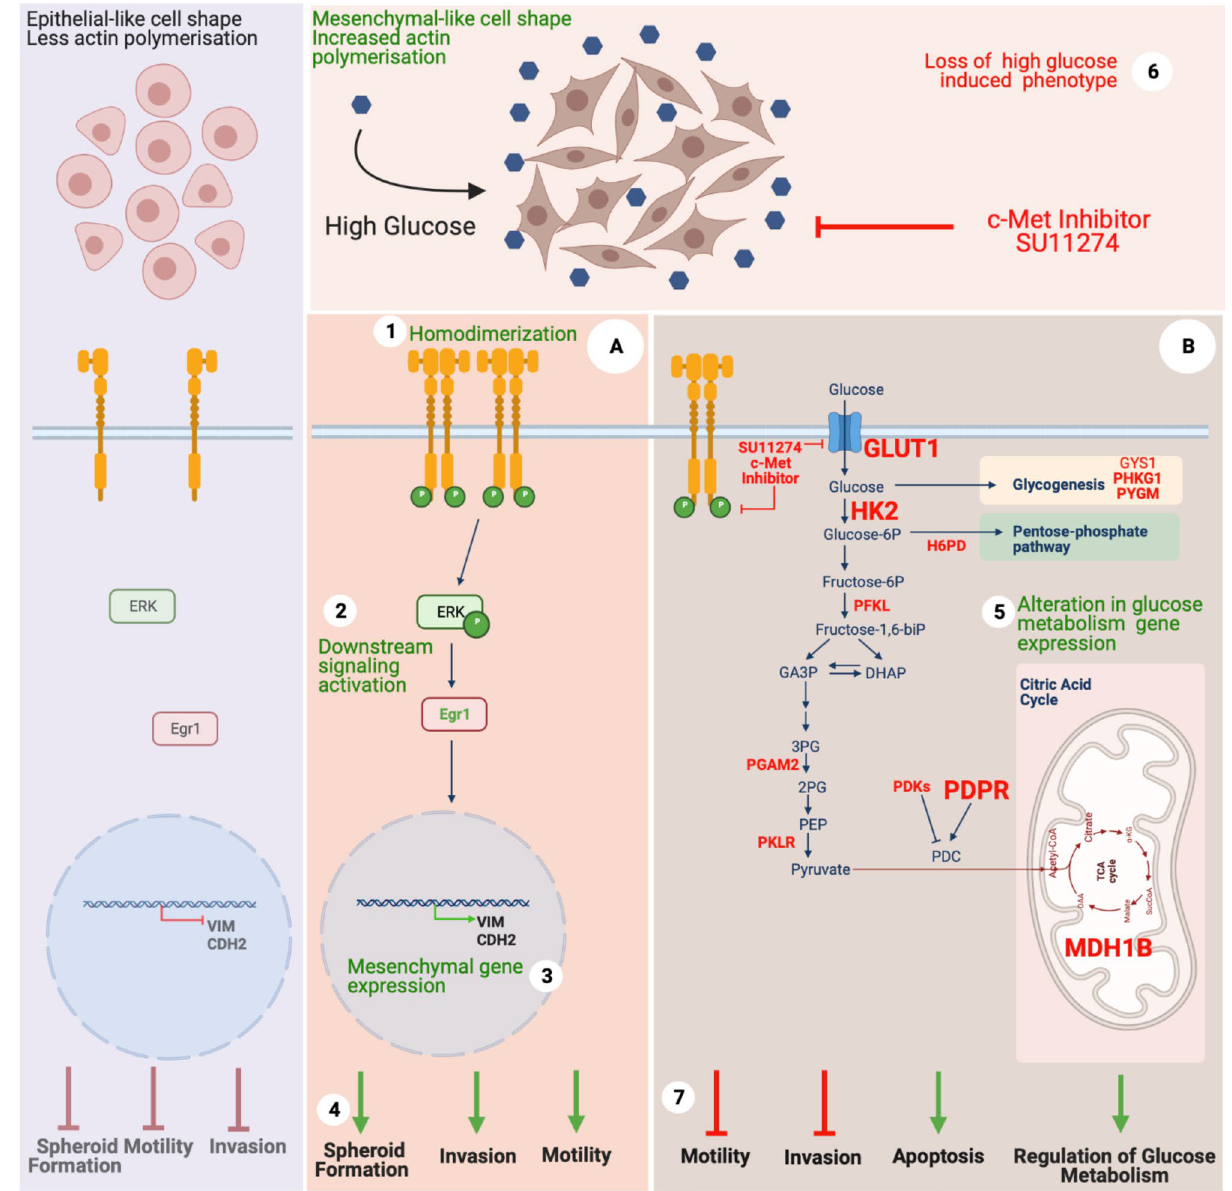
Figure 6. Graphical illustration of high glucose induced EMT via c-Met activation, its downstream signaling and associated biological cellular responses in high glucose and c-Met inhibited conditions. Green and red colored mechanisms represent active and inhibited c-Met signaling conditions, respectively. Molecular mechanisms defined in this study are summarized and numbered as following: ( 1 ) High glucose induces ligand- independent homodimerization of c-Met which in turn ( 2 ) activation of c-Met and downstream signaling, ( 3 ) promotes mesenchymal phenotype via inducing Vimentin ( VIM ) and N-Cadherin ( CDH2 ) expression, ( 4 ) induces motility, invasion and spheroid formation ability. ( 5 ) Inhibition of c-Met activity by a small molecule inhibitor (SU11274) alters expression of glucose metabolism genes, ( 6 ) reverses high glucose induced mesenchymal-like phenotype and ( 7 ) aggressive behavior and eventually sensitizes HCC cells to glucose toxicity and promotes apoptosis. c-Met activated ( A ) and inhibited ( B ) conditions. Glucose metabolism genes which are confirmed with only one cell line are typed in with standard fonts, two cell lines are typed in with “bold” fonts and the genes confirmed in both in-vitro and bioinformatic analyses are typed with “big bold” fonts. Created with